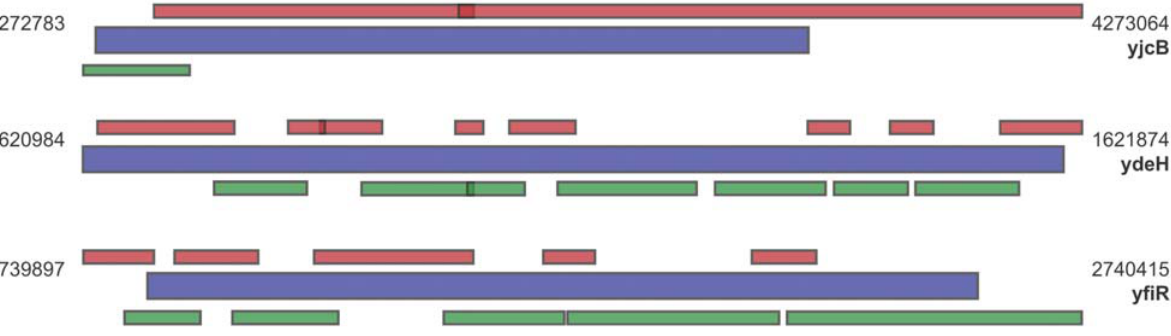
Figure 8. Genes reported as differentially and similarly expressed. A visualisation graph of how several regions can cover one single gene. The blue bars represent genes, differentially expressed regions are represented by the brown horizontal bars above the genes and similarly expressed regions are represented by the green bars below. The numbers indicate genomic start and stop coordinates.